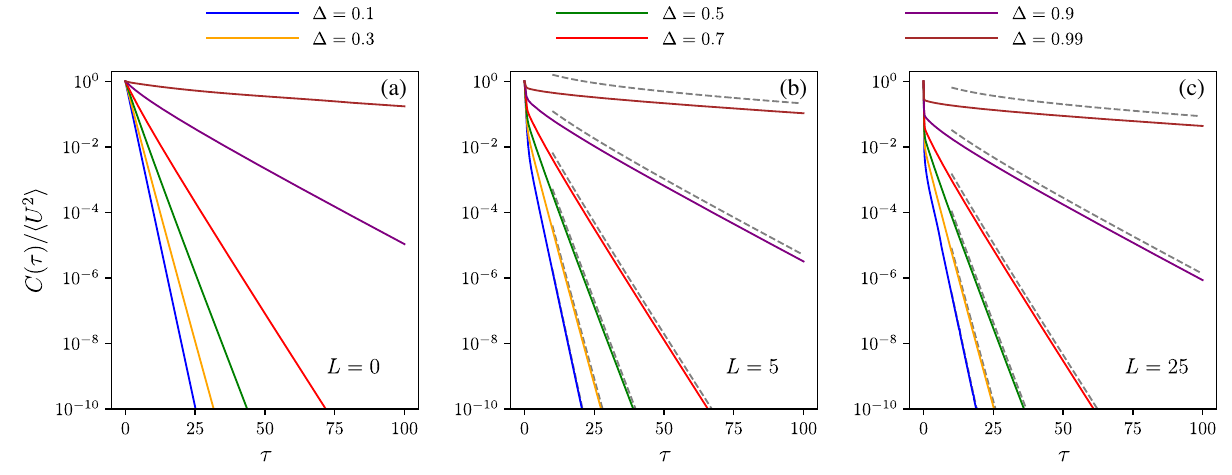
FIG. 5. The temporal correlation function C ð τ Þ as a function of the dimensionless time τ for various values of Δ . (a) L ¼ 0 , (b) L ¼ 5 , and (c) L ¼ 25 . The solid lines are calculated by numerically evaluating Eqs. (63) and (62), while the dashed lines in (b) and (c) are the analytic approximation of the asymptotic behavior for τ → ∞ [Eq. (77)]. The legend applies to all